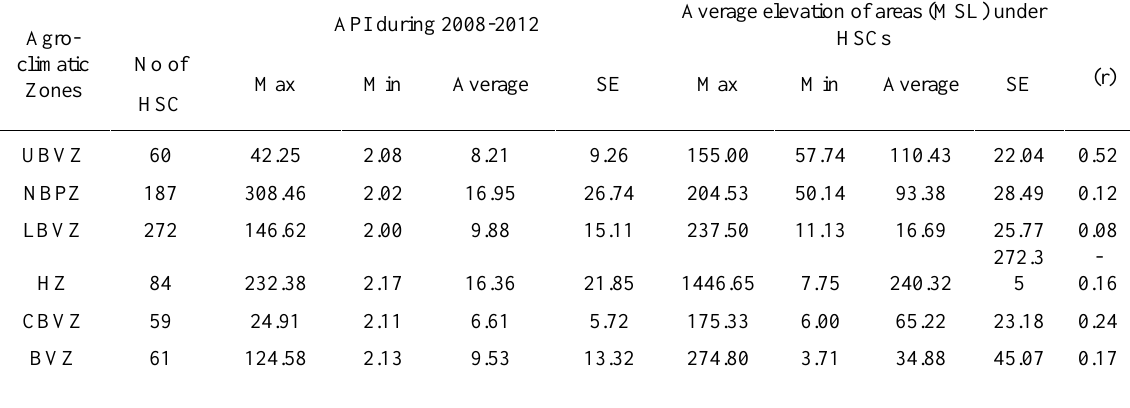
Table 3. Correlation of Malaria incidence hotspots with elevation Agro-